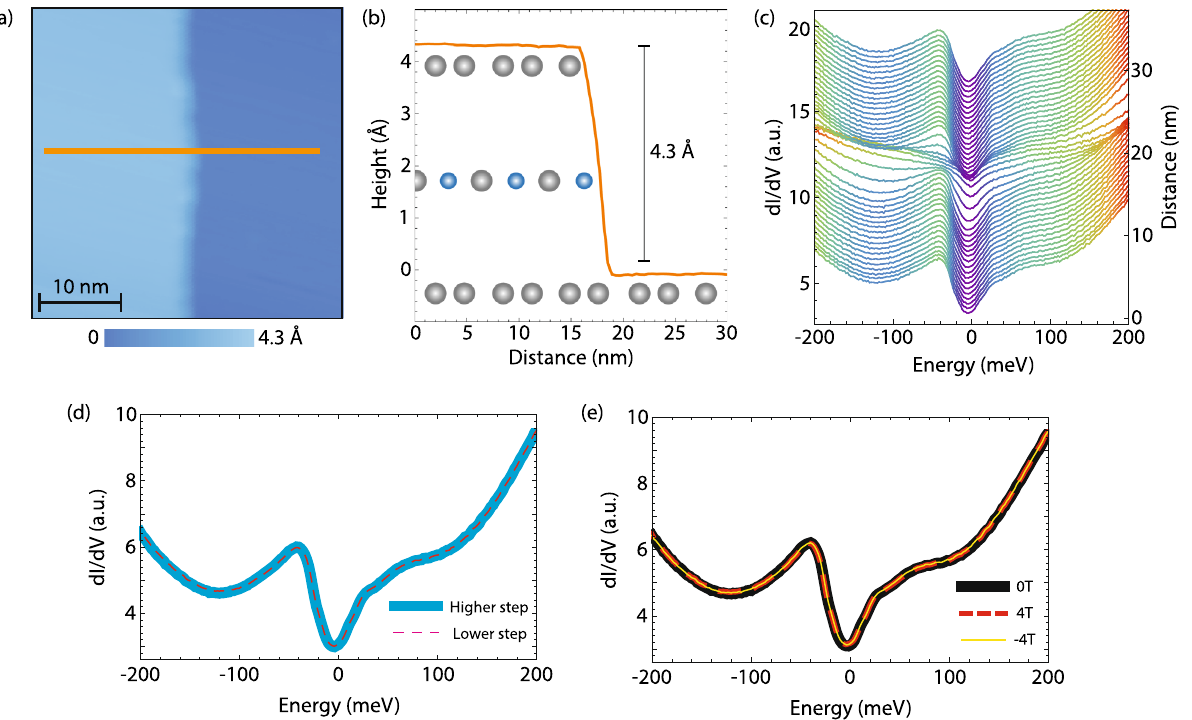
Figure 2. Absence of electronic band structure tunability with magnetic field. ( a ) STM topograph across a step between two Sn terraces. ( b ) Schematic of the step in ( a ) with a topographic profile along orange line in ( a ). ( c ) Waterfall plot of dI/dV spectra along the orange line in ( a ), showing uniformity of spectra away from the edge that appear indistinguishable on either terrace. ( d ) Average dI/dV spectra on the two terraces in ( a ), overlapping one another almost exactly. ( e ) Average dI/dV spectra acquired on the higher terraces in ( a ) under 0 T and ± 4 T magnetic field applied perpendicular to the sample surface. All three spectra again appear indistinguishable. STM setup condition: ( a ) I set = 10 pA, V sample = 1 V; (c–e) I set = 800 pA, V sample = 200 mV, V exc = 2